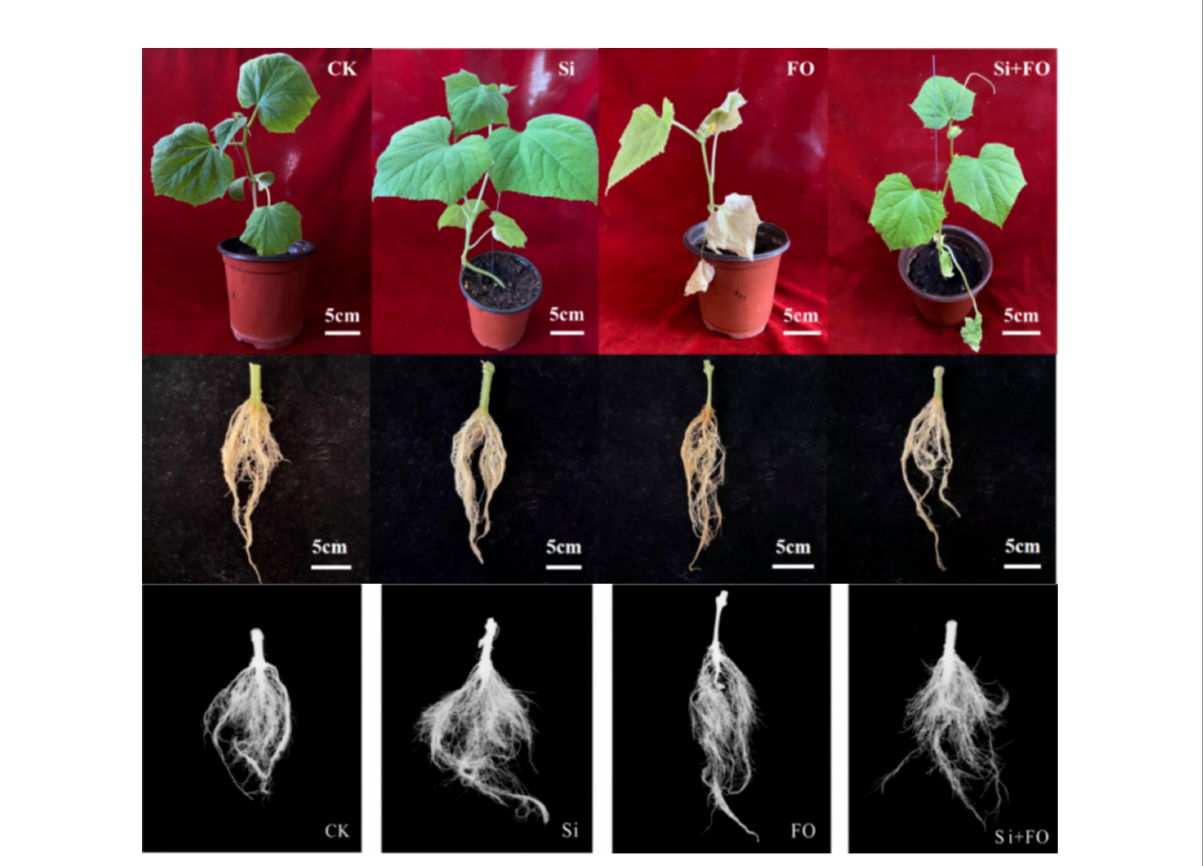
FIGURE 2 Phenotypes of cucumber plants under different treatments. Upper panels: whole plant phenotype, middle panels: root phenotype, and lower panels: images of scanned roots under different treatments. CK or control: plants were irrigated with sterilized water; Si: plants were irrigated with exogenous silicon (3 mmol·l -1 Si); FO: plants were only inoculated with Fusarium ; Si+FO: plants were irrigated with exogenous silicon followed by inoculation with Fusarium .